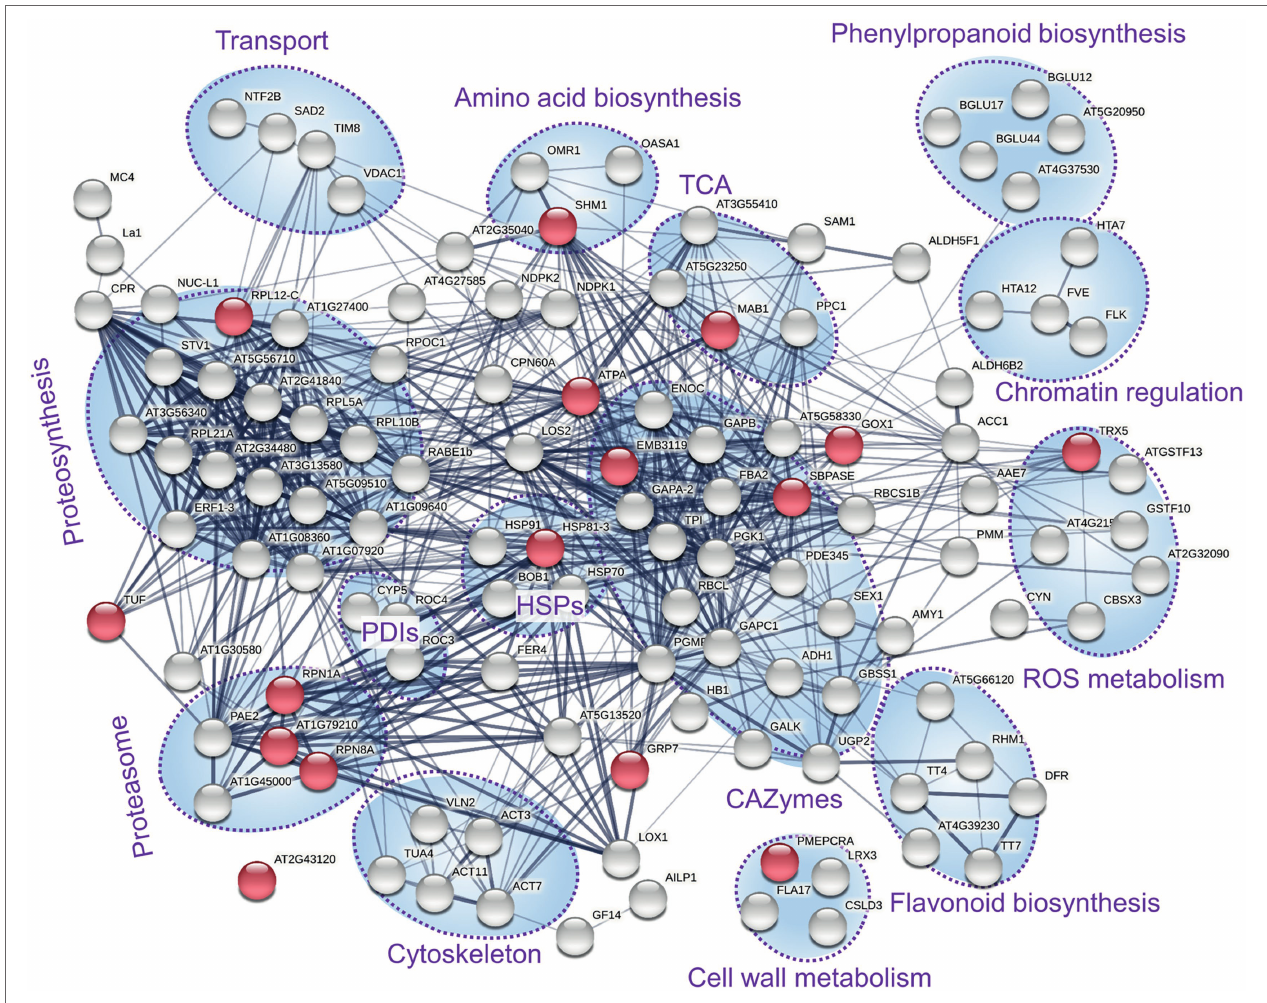
FIGURE 3 | Expected role of differentially abundant proteins found in inoculated tubers. Functional enrichment of corresponding Arabidopsis orthologs and interactions visualized by String (Szklarczyk et al., 2019). The thickness of lines indicates the strength of data support; the minimum required interaction score is 0.4 (medium confidence). Red dots indicate the defense response to other organism (GO:0098542). Clusters with at least three components are highlighted. PDIs, protein disulfide isomerases; HSPs, heat shock proteins; and TCA, enzymes associated with the tricarboxylic acid